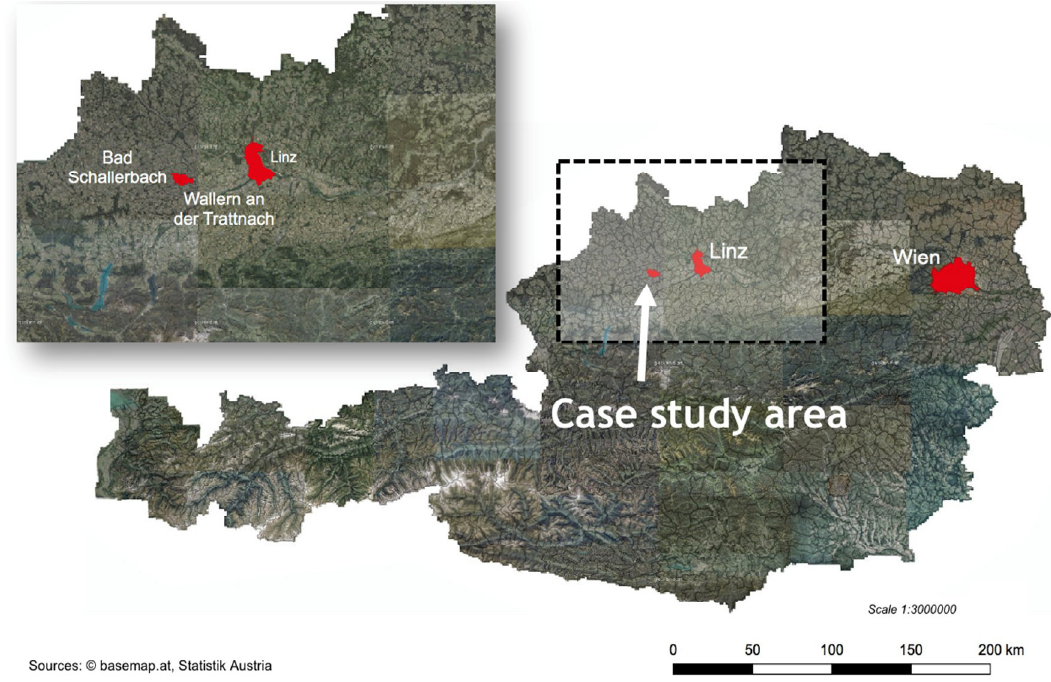
Figure 5. Location of case study area (own